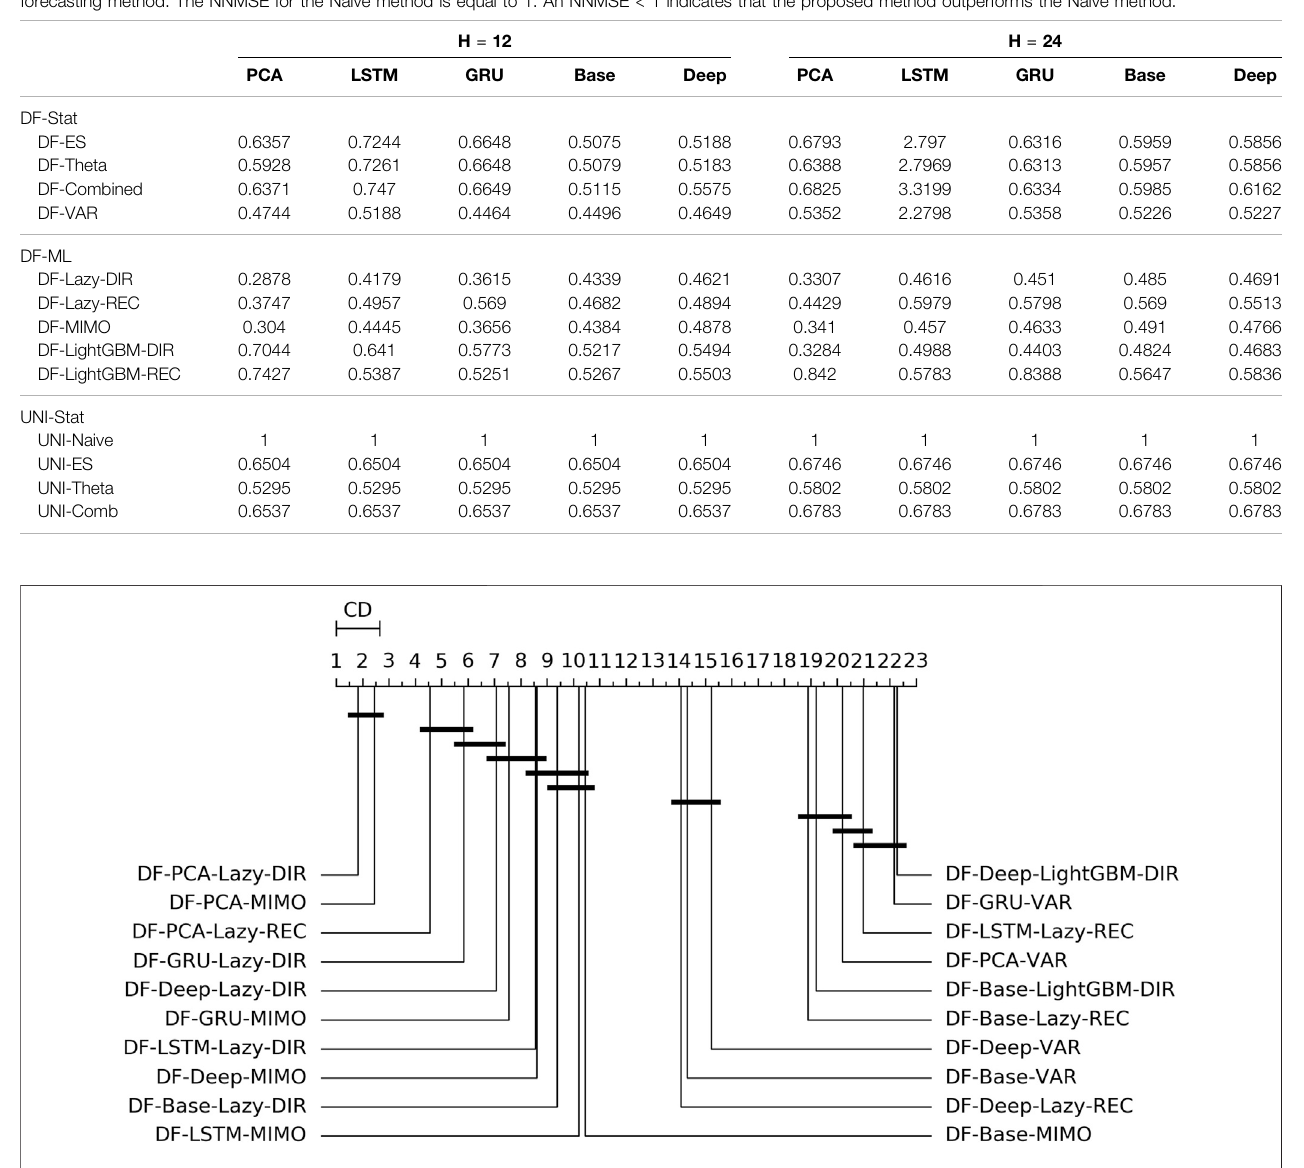
FIGURE4| Electricity — Graphicalrepresentationaccordingto(Dem š ar,2006)oftheresultsofFriedmanstatisticaltest(withpost-hocNemenyitest)comparingthe NNMSE of the best 20 methods against each other, aggregated across all horizons h . The methods are ordered according to their performance from left to right (the leftmost the best), while the black bar connects methods that are not signi fi cantly different (at p (cid:1) 0.05).